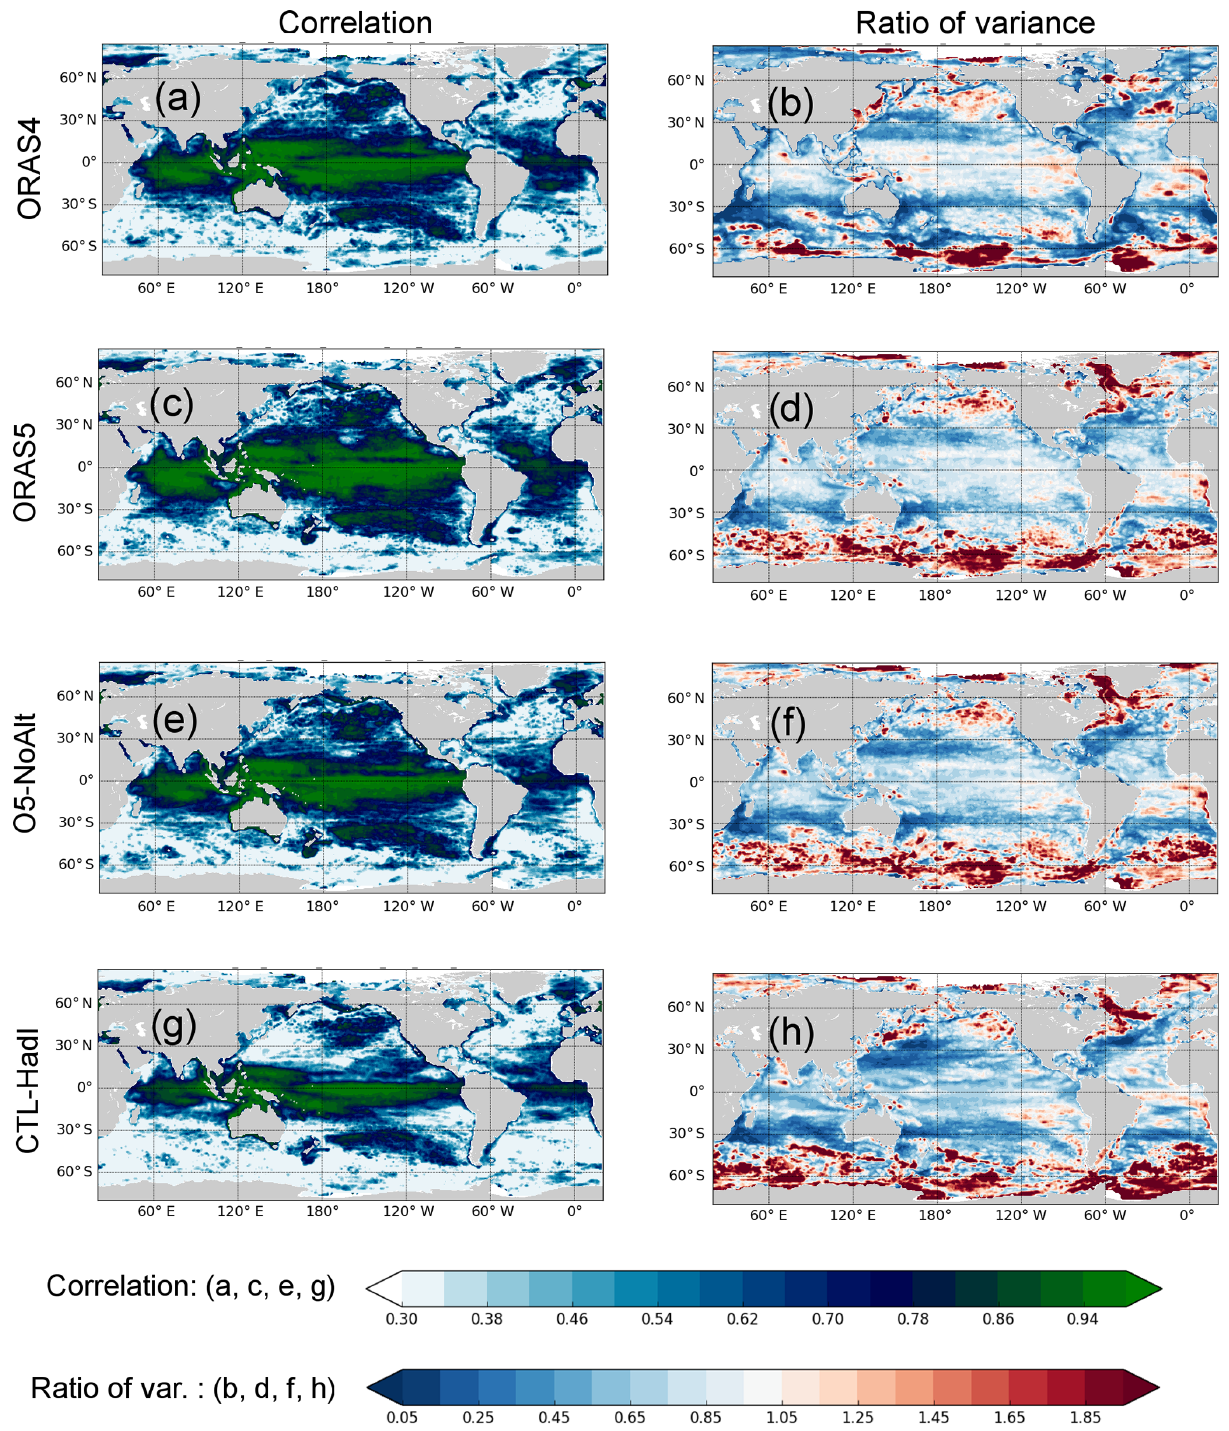
Figure 21. (a, c, e, g) Temporal correlation and (b, d, f, h) ratio of variance between SLAs from ocean syntheses and SL_cci2. Ocean synthesis SLAs are from (a, b) ORAS4, (c, d) ORAS5, (e, f) O5-NoAlt and (g, h) CTL-HadIS. Statistics are computed using monthly-mean SLA data over the 2004–2013 period; temporal correlations are diagnosed after removal of the seasonal cycle. Note that correlations smaller than 0.3 are shown as